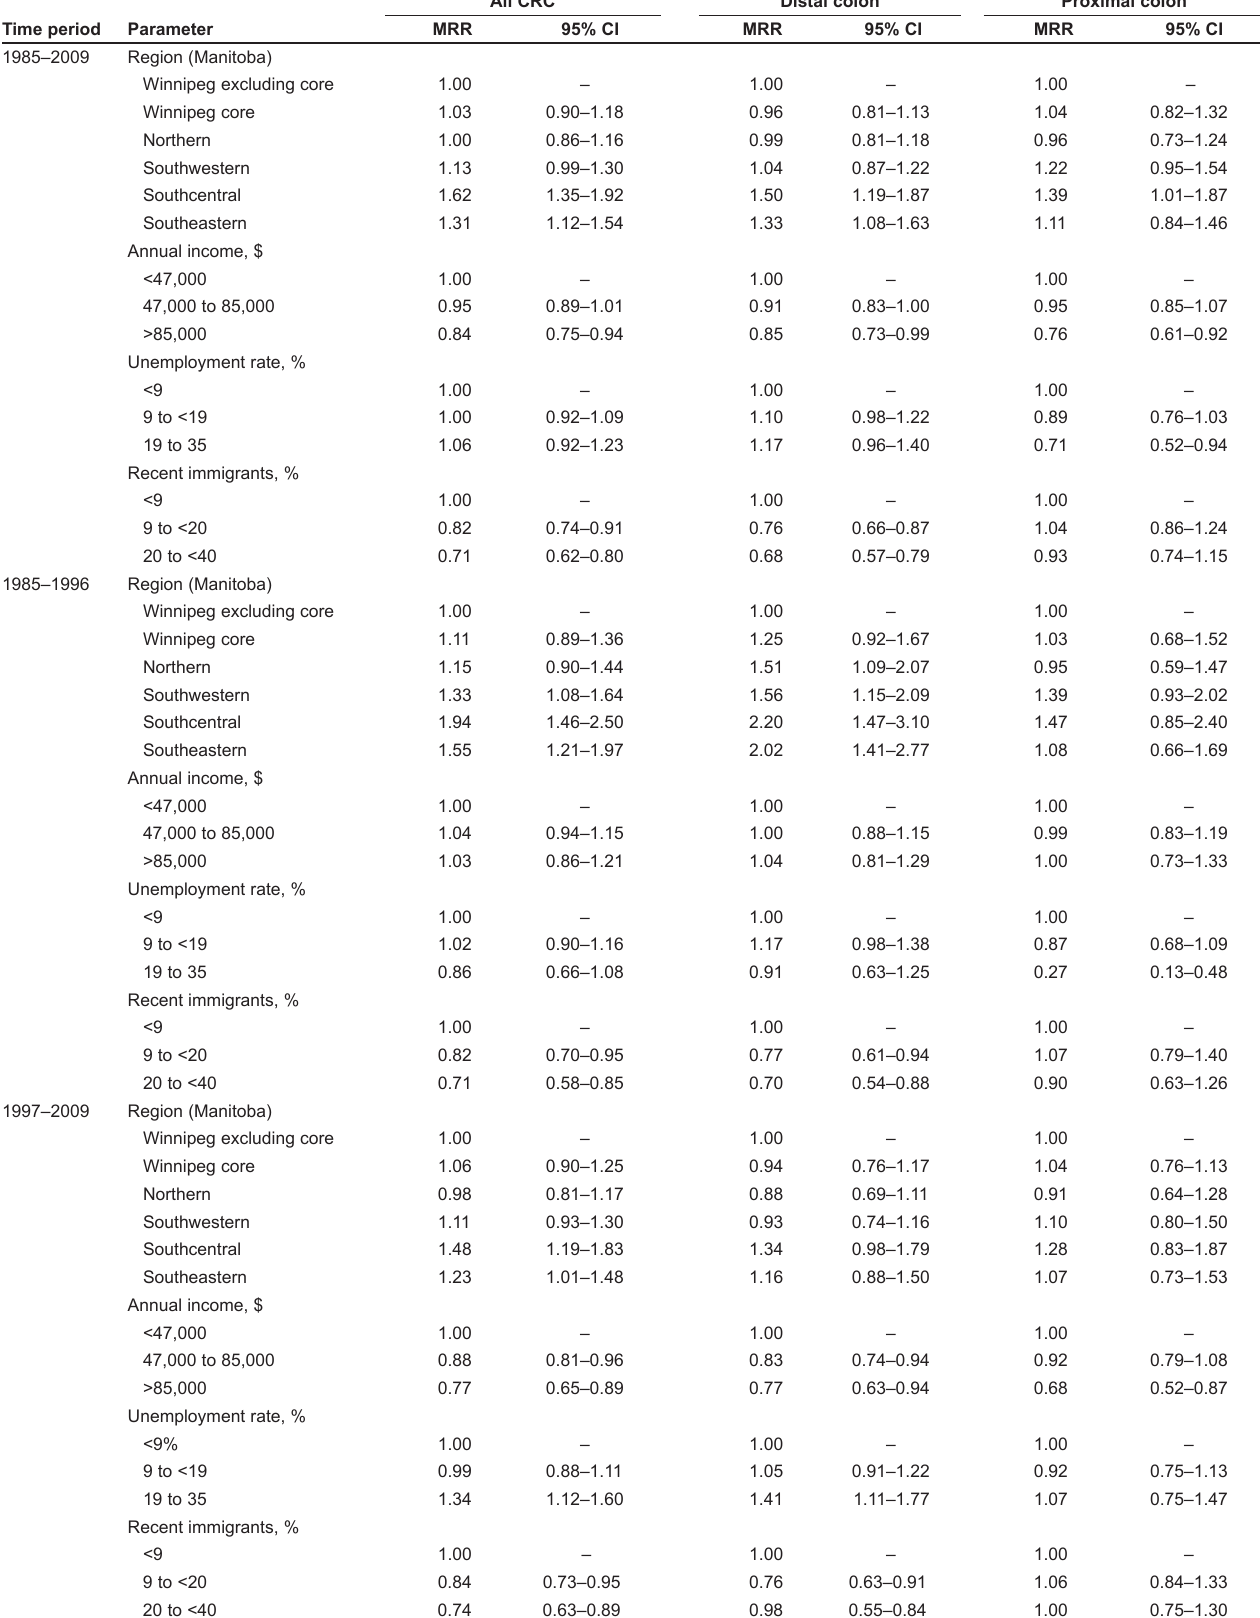
TABle 4 Adjusted saturated Poisson regression analysis of colorectal cancer (CRC)